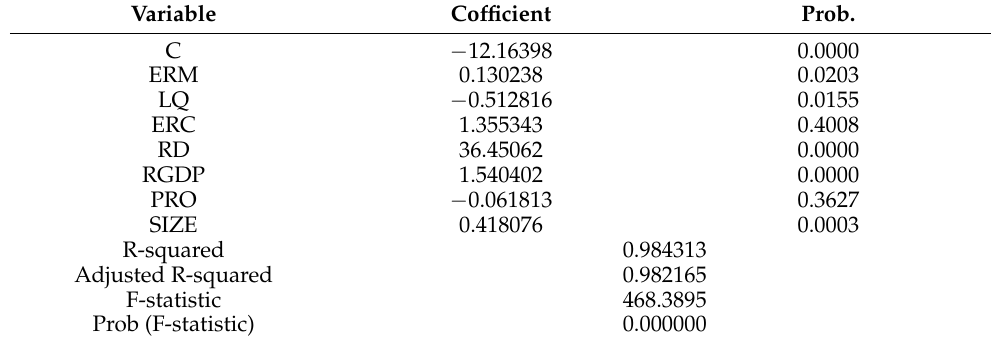
Table 10. Regression results of the effect of environmental regulation and industrial agglomeration on eco-innovation performance.